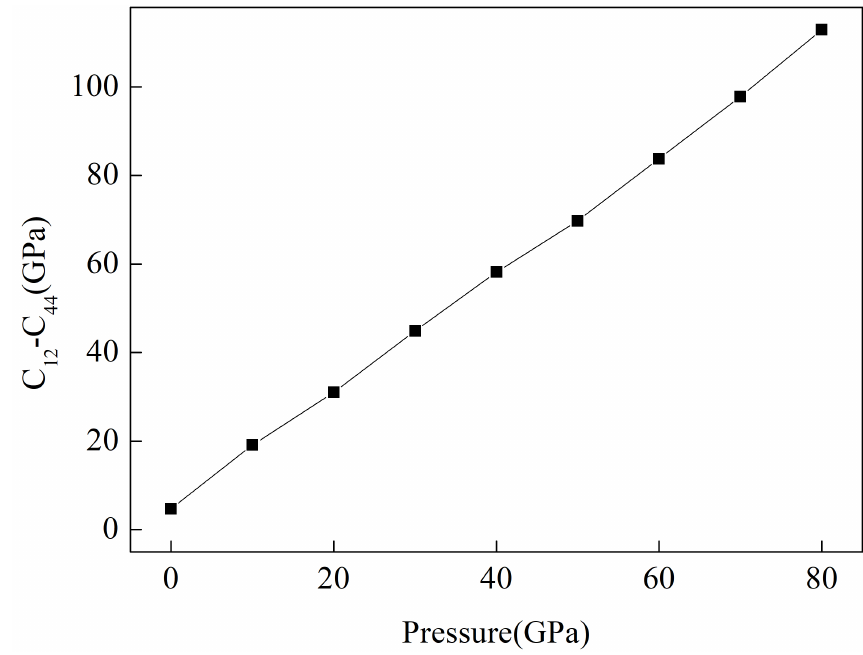
Figure 7. Cauchy pressures C 12 − C 44 as a function of pressure for β -Mg 17 Al 12